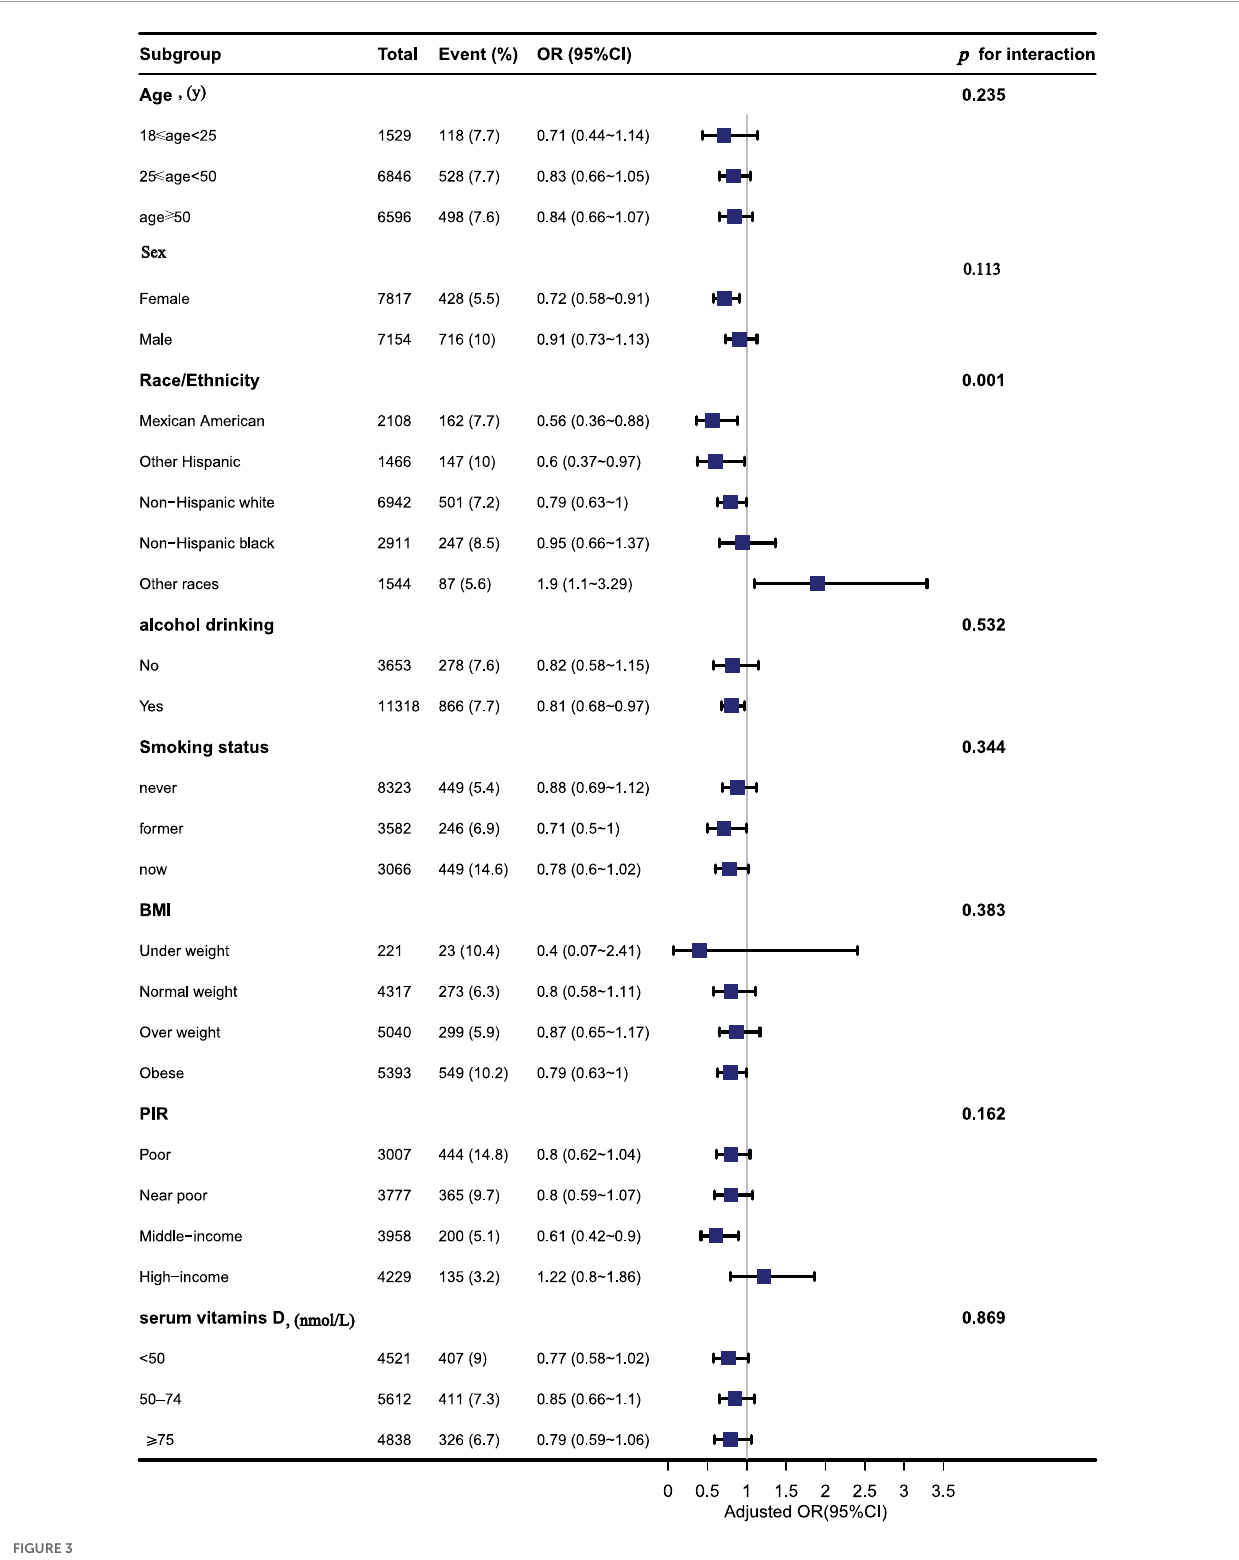
FIGURE3 The association between dietary calcium (Ca) intake and depressive symptoms in different